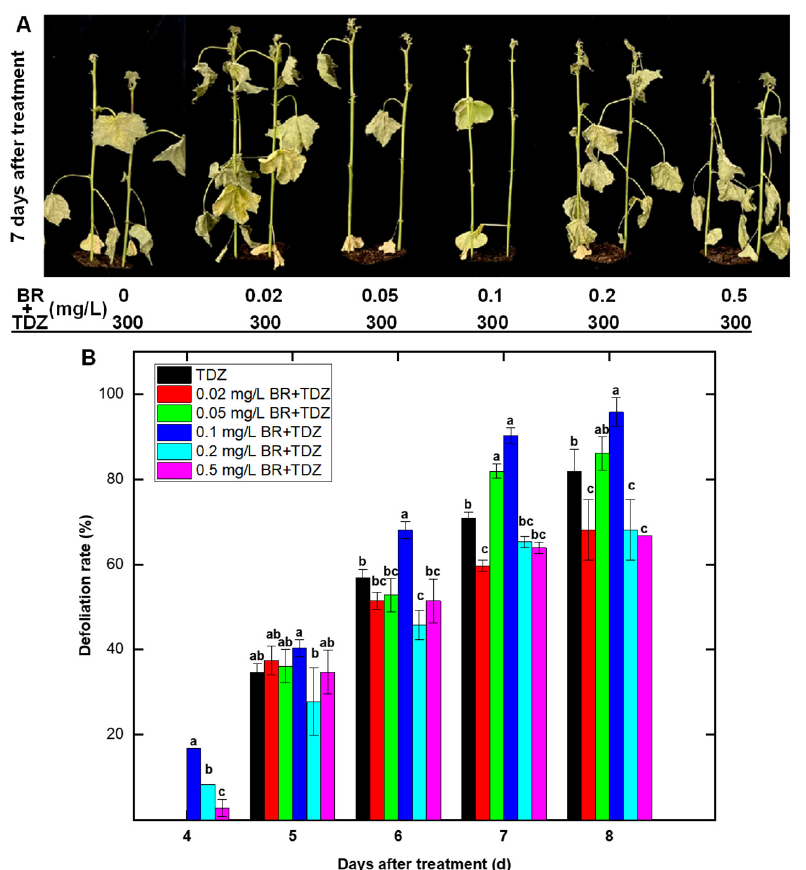
Figure 7. Effect of brassinosteroid (BR) pretreatment (2 h in advance) on thidiazuron (TDZ)-induced cotton leaf abscission. ( A ) Representative plants at 7 d after treatments. ( B ) Defoliation rate (%) over time after treatments. Homogeneous subgroups with significant difference ( p -value < 0.05) are marked by different lowercase letters.